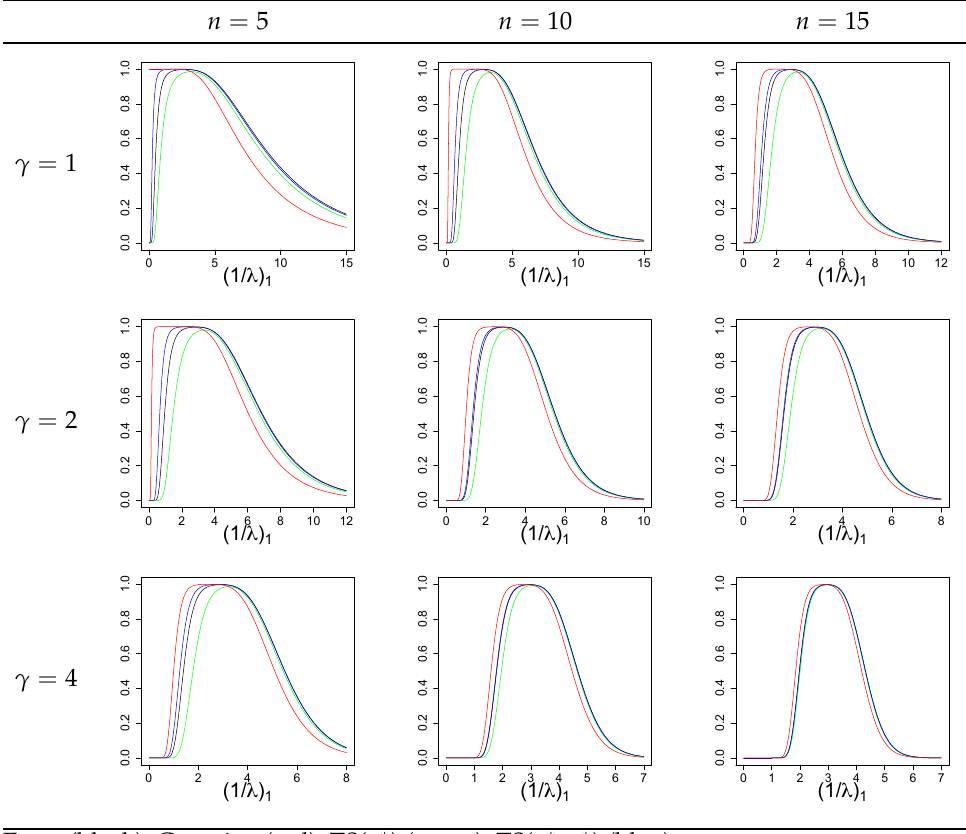
Figure 5. Operating characteristic (OC) curves of an ¯ X chart with subgroups of size n for a Gamma ( γ , 1 is the in-control